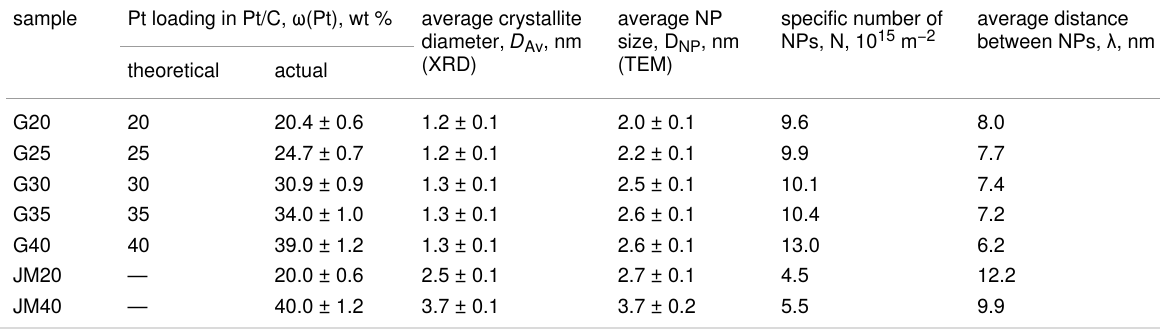
Table 1: Parameters characterizing the composition and structure of Pt/C catalysts.